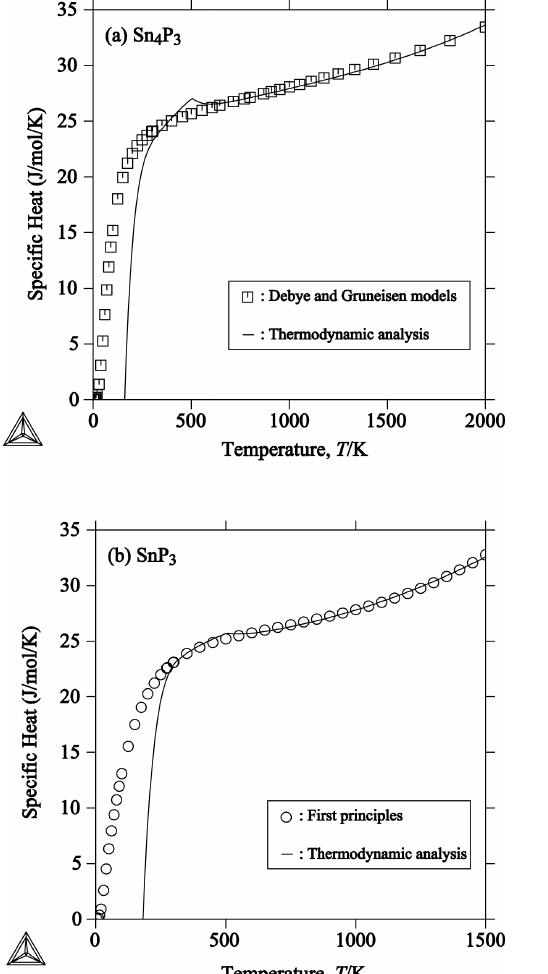
Comparison of calculated activities of Sn and P in the liquid phase with experimental values at (a) 550°C and (b)